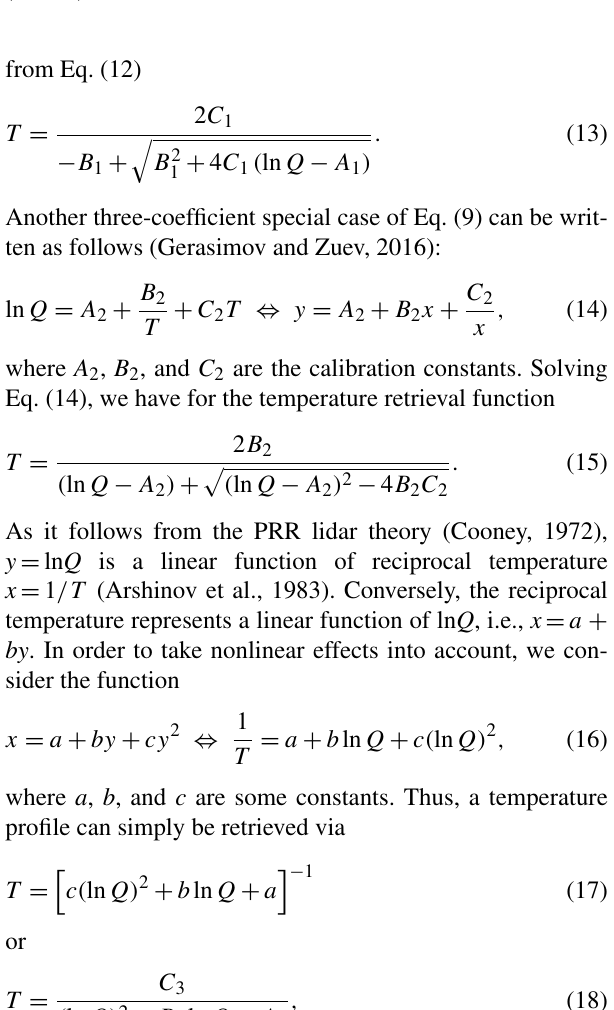
Figure 4. Temperature profiles from radiosondes launched on 1 April 2015 at 06:00LT (00:00UTC) in Novosibirsk (sta- tion 29634) and Kolpashevo (station 29231) as well as temperature points over Tomsk retrieved from constant pressure altitude charts